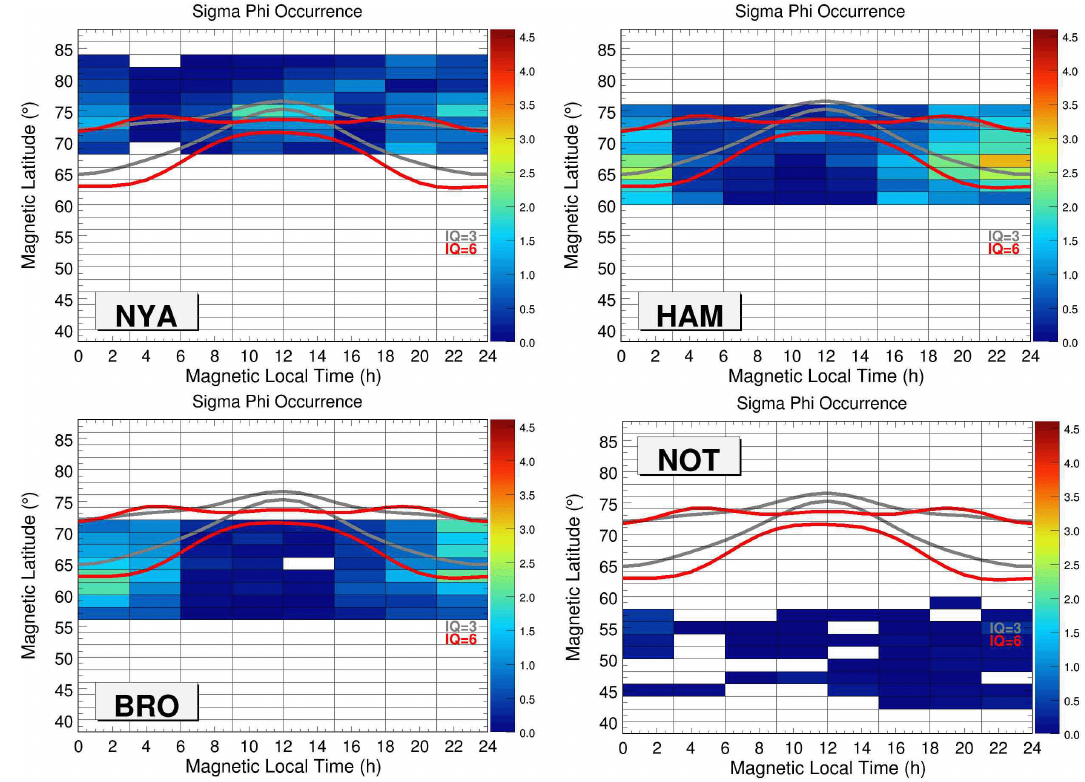
Fig. 6. Phase scintillation maps of all days and for each station separately. In grey the Feldstein oval for IQ=3, while in red the one for IQ=6.